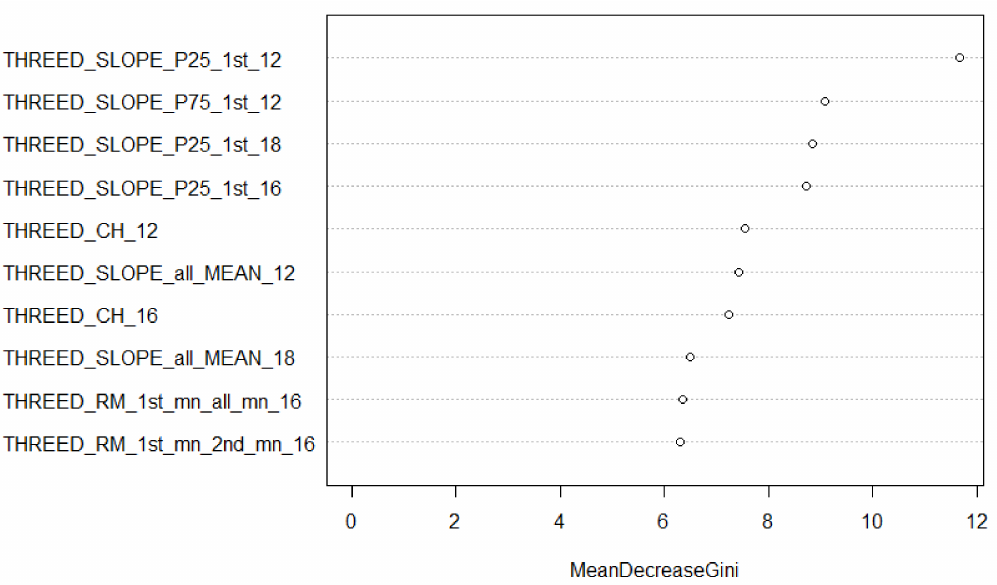
Figure 5. Mean Decrease Gini features for the 12 species classification (all sensors, top 10 3D features only). The suffix after each feature (_12, _16, _18) refers to the dataset (ALS12, MSL16, SPL18) from which the feature was